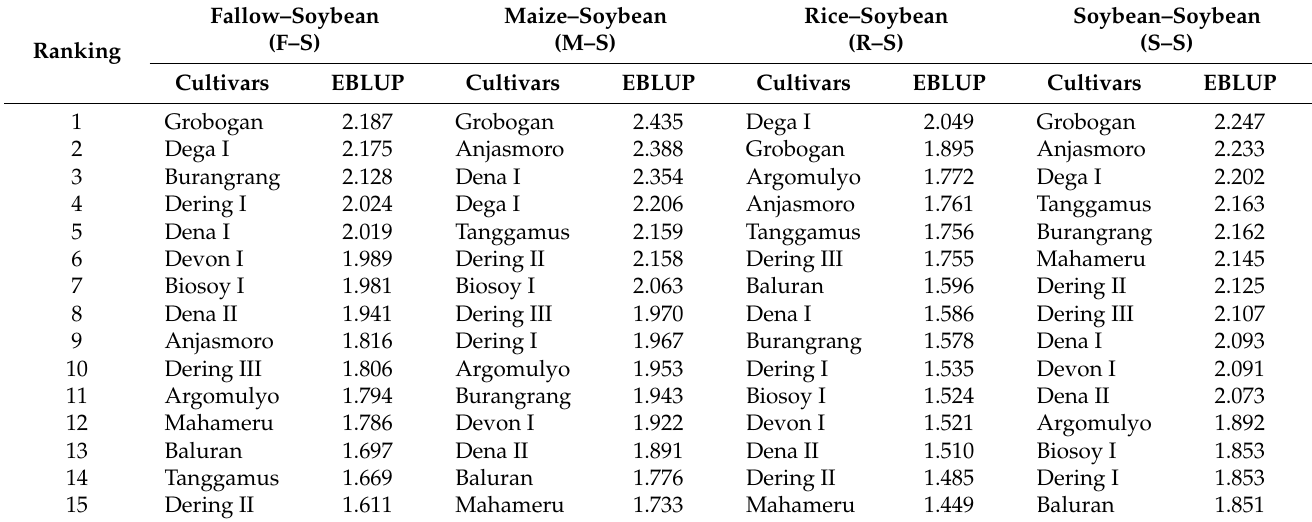
Table 7. Ranking and empirical best linear unbiased prediction (tons ha − 1 ) of 15 soybean cultivars in each crop rotation model during the dry